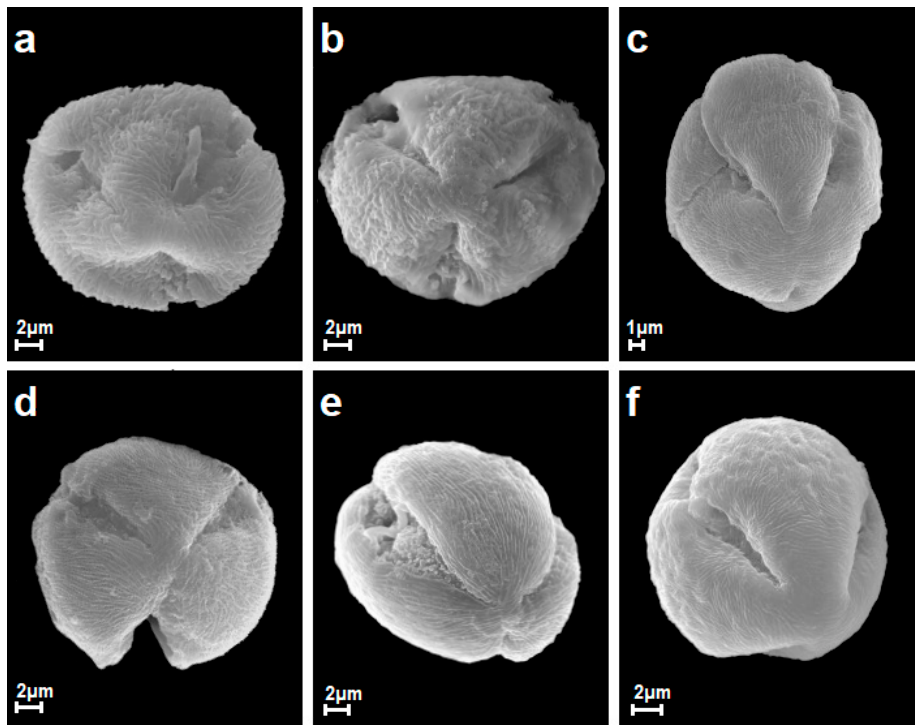
Figure 4. Pollen grains of Rubus caesius , R. idaeus , R . henrici-egonis , R . plicatus , R . radula and R . saxatilis in polar view, ( a – f ).